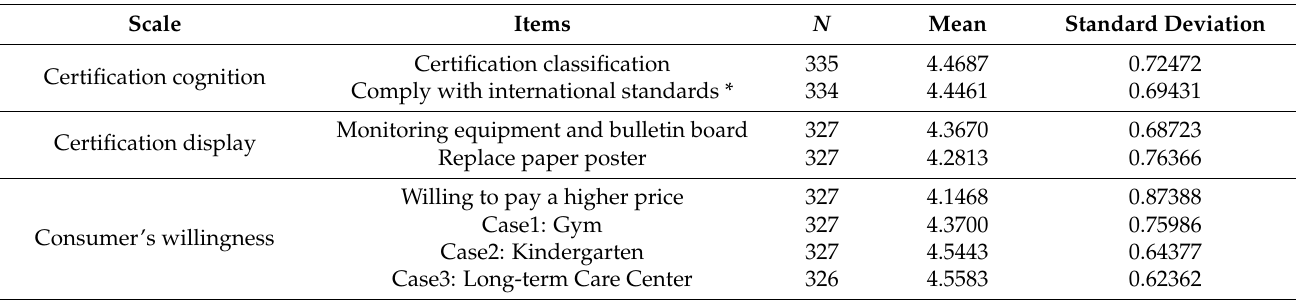
Table 8. The IAQ Certification cognition, displays, and the consumer’s